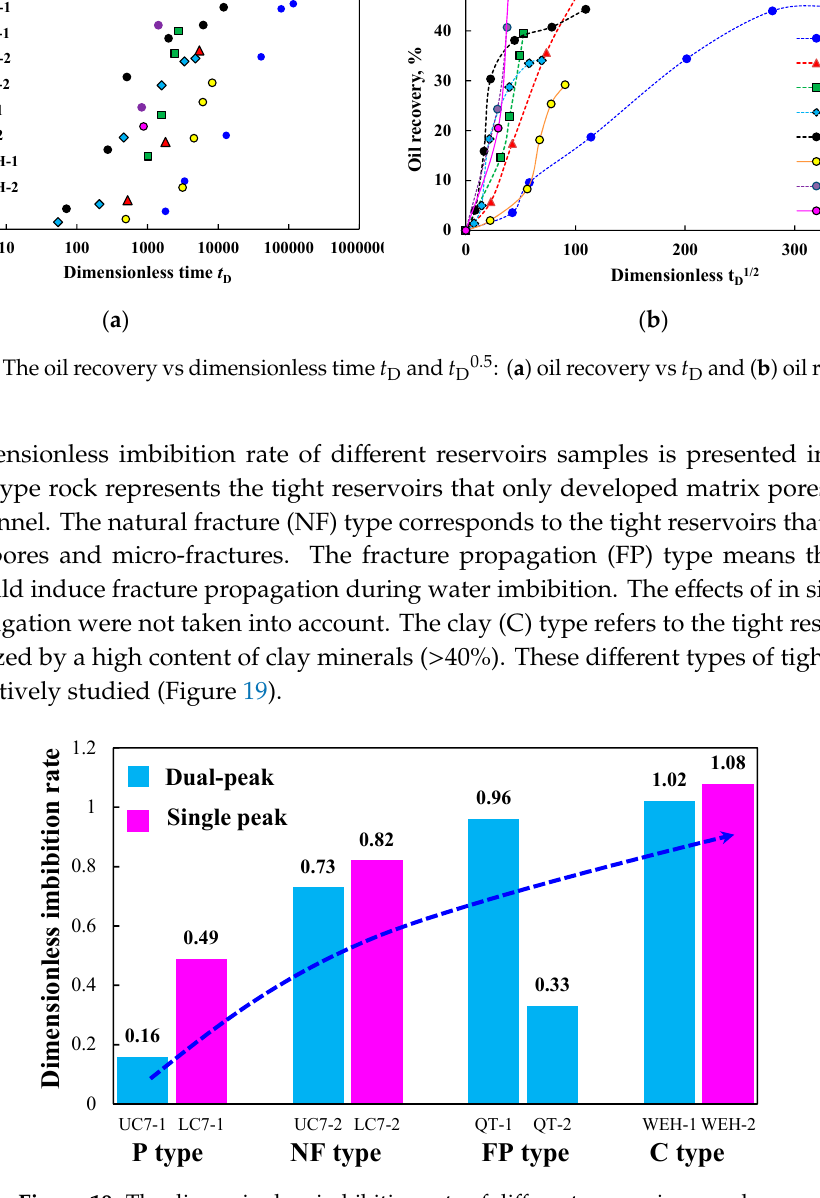
Figure 19. The dimensionless imbibition rate of different reservoirs samples.